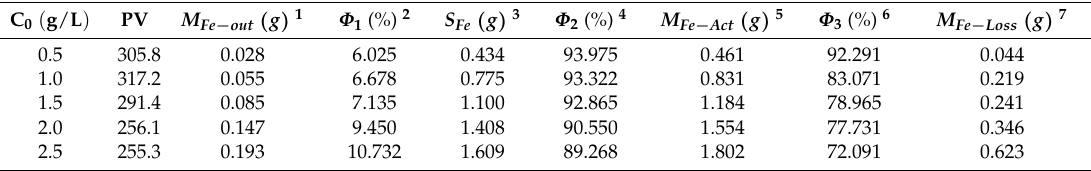
Table 4. Amount of iron retained in column and effluents, and mass loss.